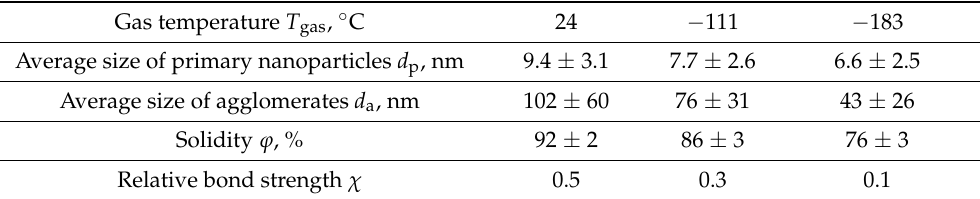
Table 2. Results of analysis of TEM images of gold nanoparticles obtained in a nitrogen atmosphere at T gas equal to 24 ◦ C, − 111 ◦ C, and − 183 ◦ C.